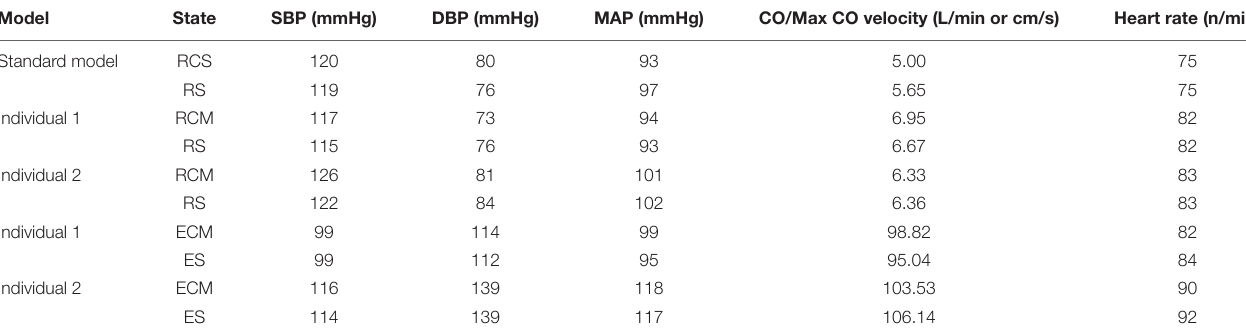
TABLE 4 | The clinical physiological data of clinical measurements and simulated